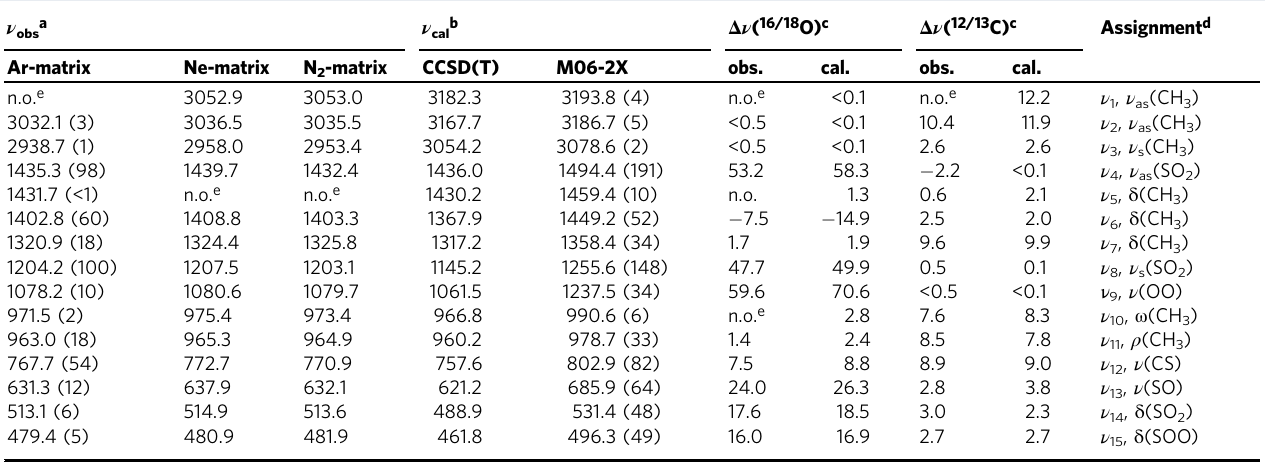
Table 2 Observed and calculated IR data (>400 cm − 1 ) for CH 3 S(O) 2 OO (cid:129) . ν a ν obs